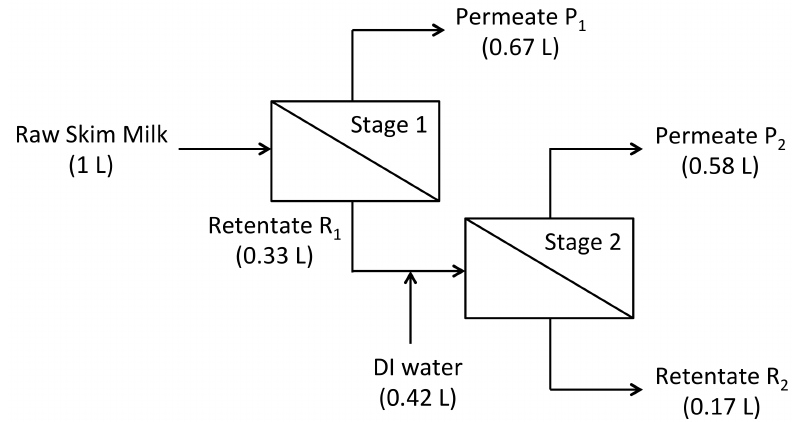
Figure 2. Schematic diagram for milk protein concentrate (MPC) manufactured from skim milk using concentration and diafiltration. The membranes used in Stages 1 and 2 were the